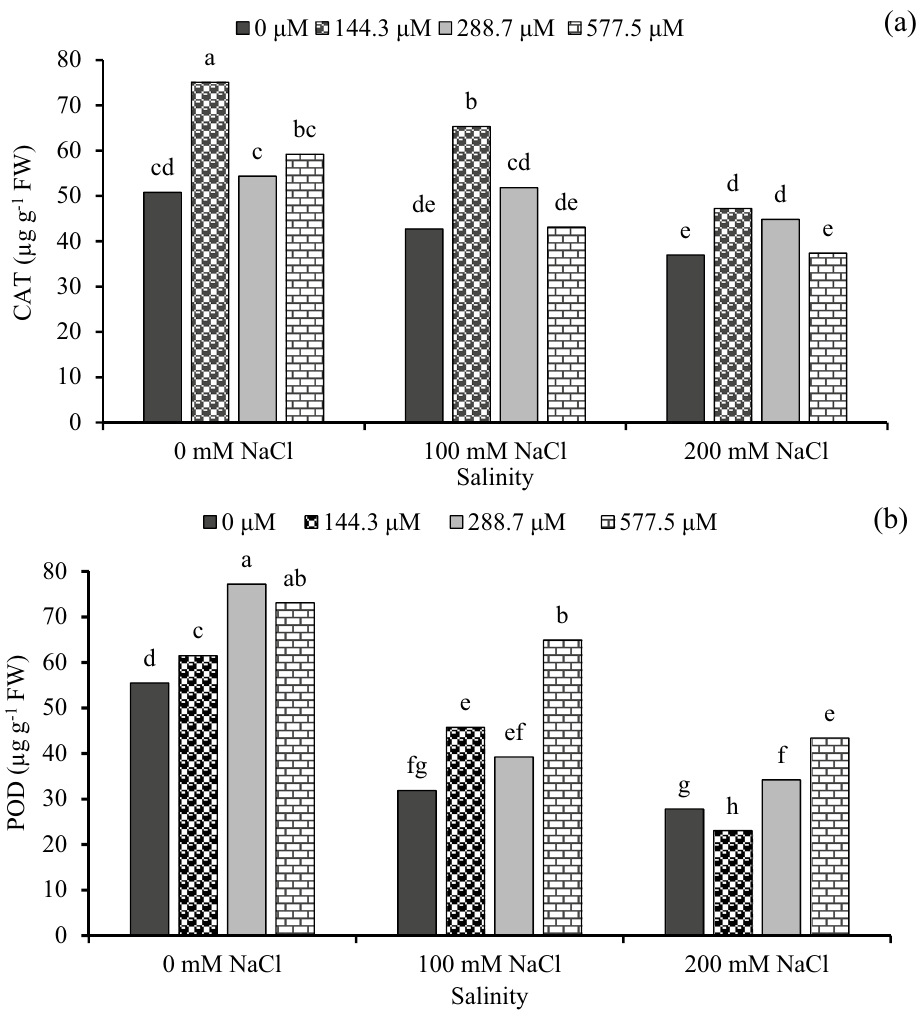
Figure 3. The effect of interaction between different concentrations of salinity × different concentrations of gibberellic acid (GA 3 ) on ( a ) catalase (CAT) and ( b ) and peroxidase (POD) activities of sorghum seedling. Bars with different letters are significantly different at the 0.05 probability. Means were separated by the LSD